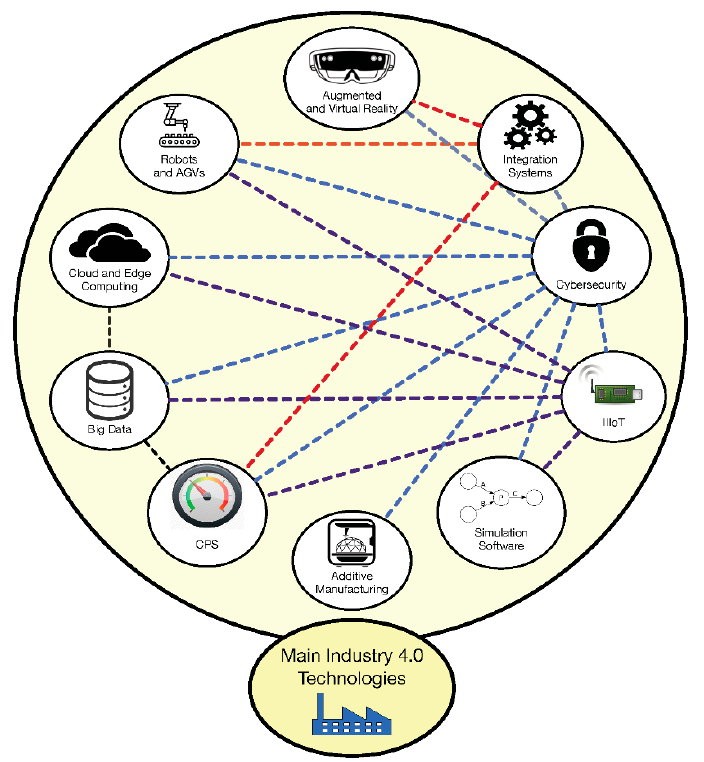
Figure 1. Main technologies of Industry 4.0 [54].